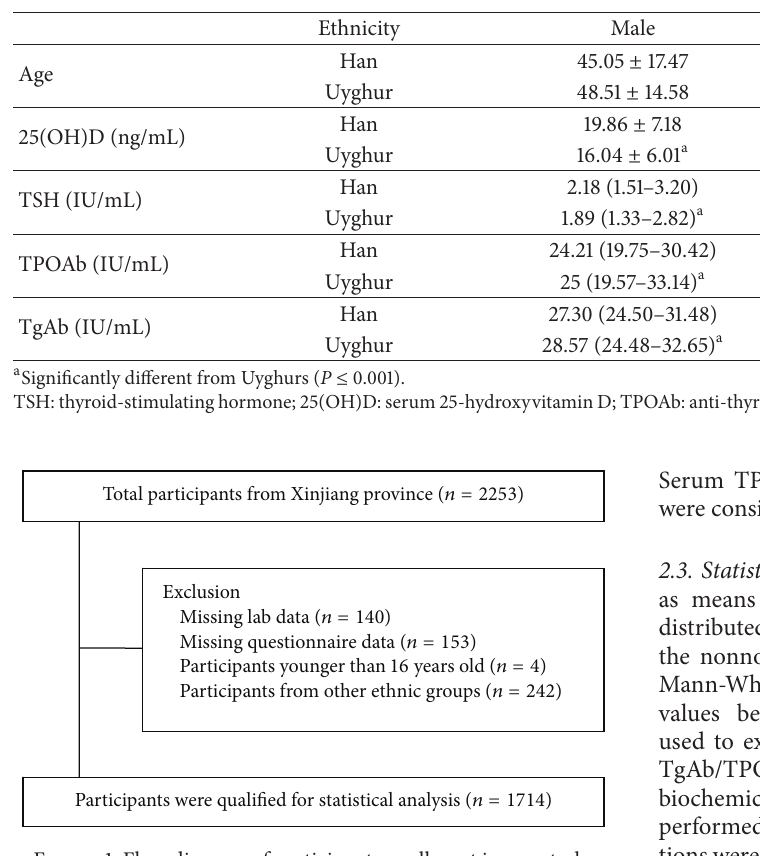
Table 1: Clinical characteristics for the participants.